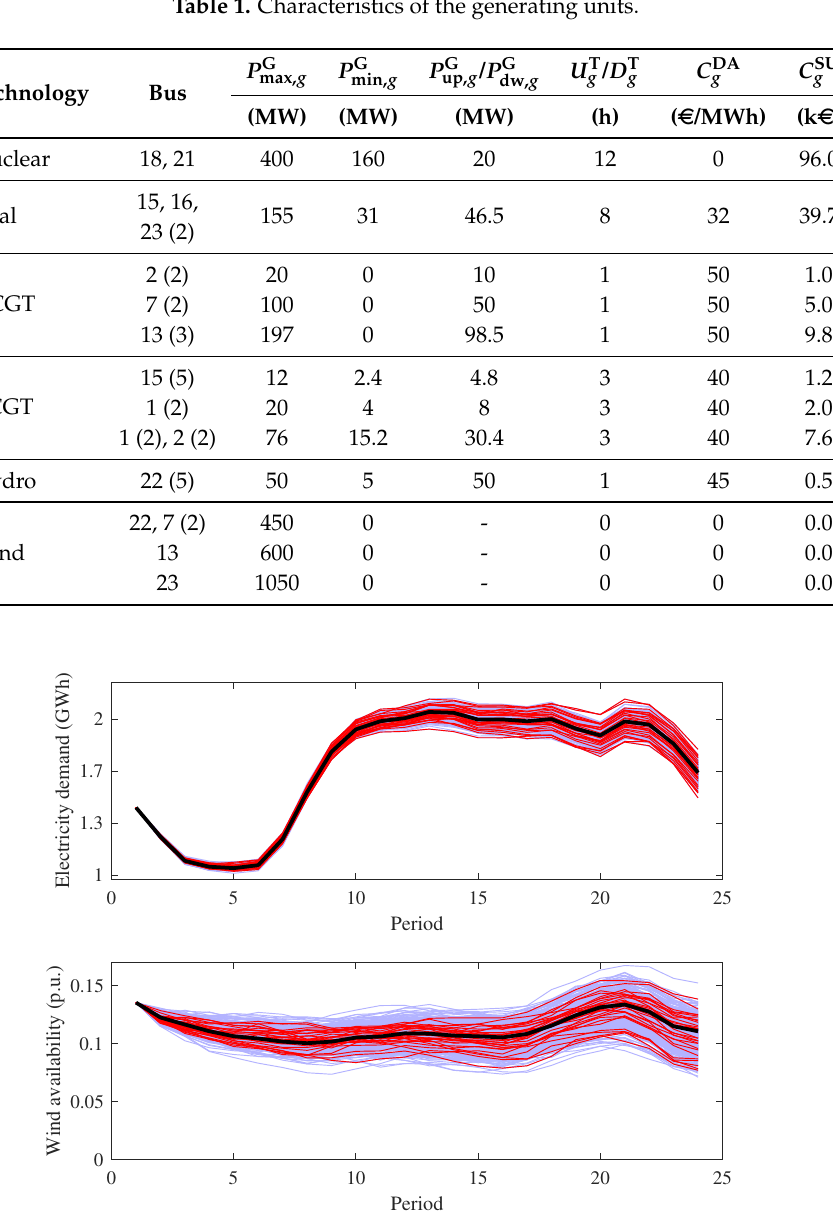
Table 1. Characteristics of the generating units.